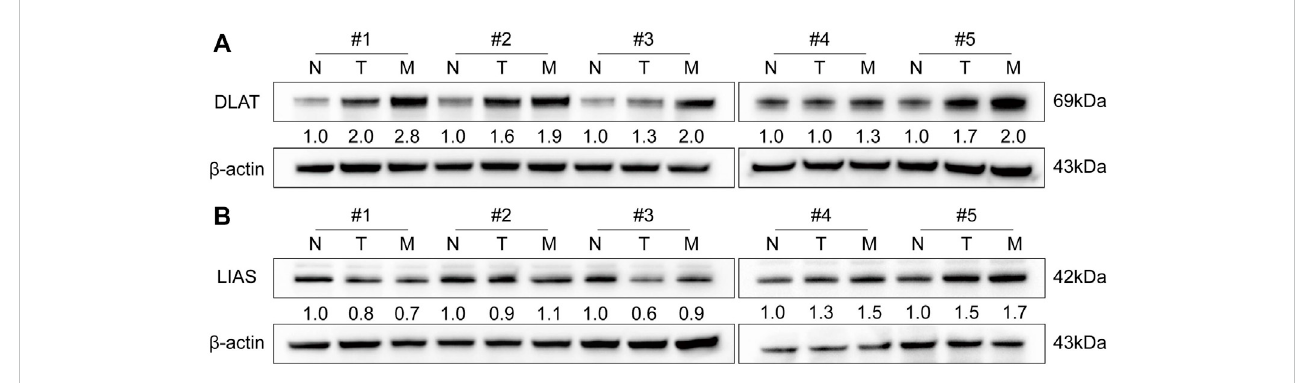
FIGURE 5 The expression signature of DLAT and LIAS in fi ve pairs of HCC and adjacent non-tumor samples and fi ve metastatic HCC specimens. (A) DLAT. (B)